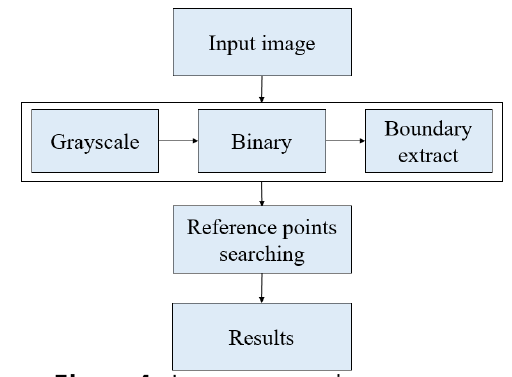
Figure 4. Image processing process.